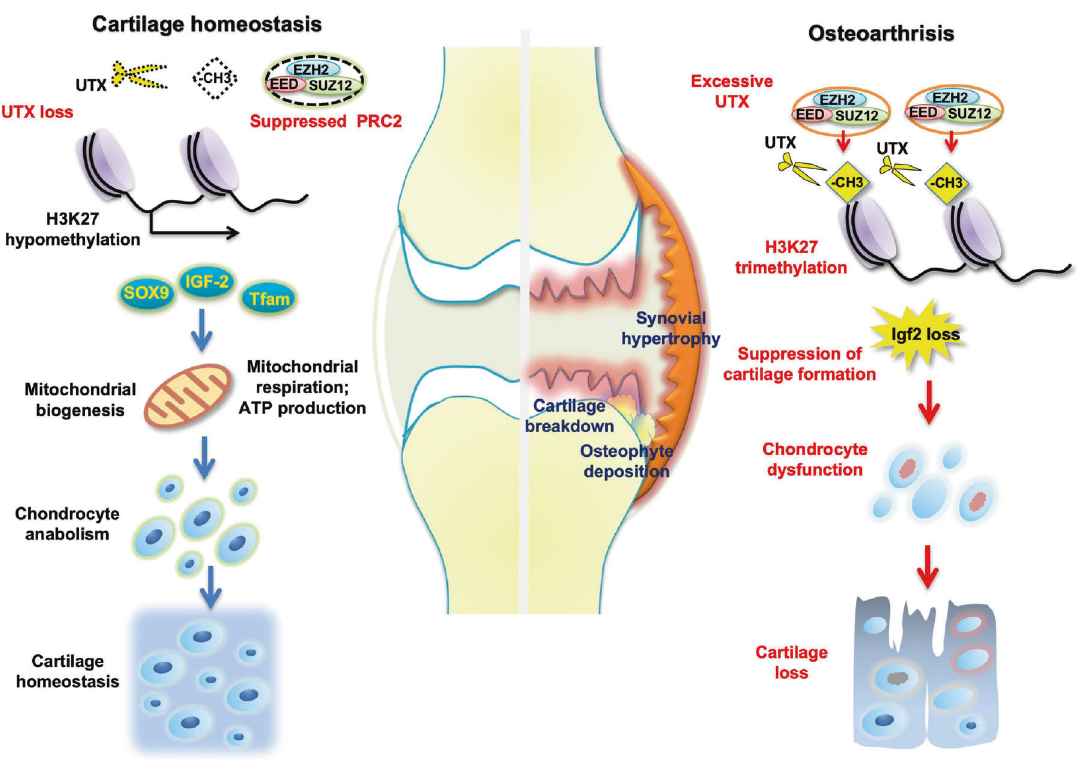
Fig. 8 Schematic illustration of how epigenetic changes affect cartilage ECM integrity. Age-dependent changes in articular chondrocytes that are leading to an increased UTX activity (i.e., mimicked by lentiviral overexpression) are, together with histone writer PRC2 core components EED and SUZ12, resulting in an elevated histone methylation state in these cells, consequently dysregulating cartilage homeostasis. Also, this epigenetic signature suppresses SOX9 activity, which is crucial for maintaining ECM integrity. Ultimately, this culminates in the development of OA. In contrast, inhibiting UTX facilitates transcriptional activity at promoter regions of certain cartilage key markers (like e.g., SOX9, Col2a1, ACAN) at least partially through co-suppression of Eed and Suz12. This net stimulation of anabolic factors then aids in maintaining the ECM integrity of the tissue to ensure proper